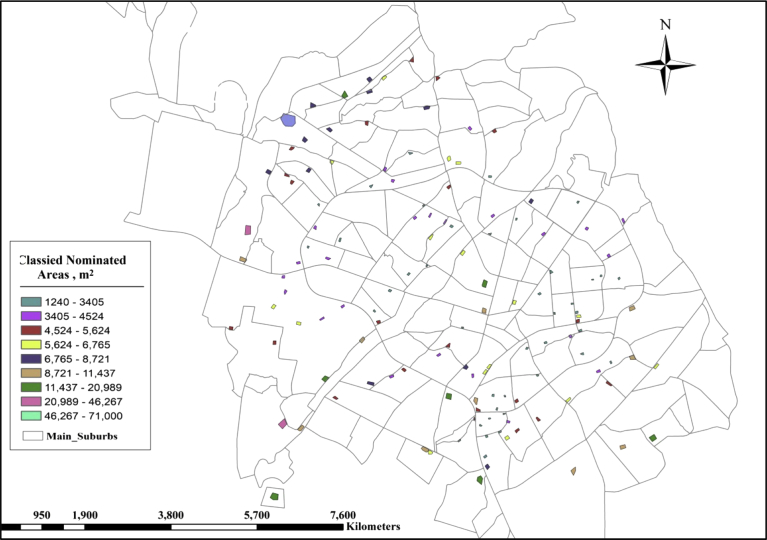
Classified nominated areas – based on size of areas.